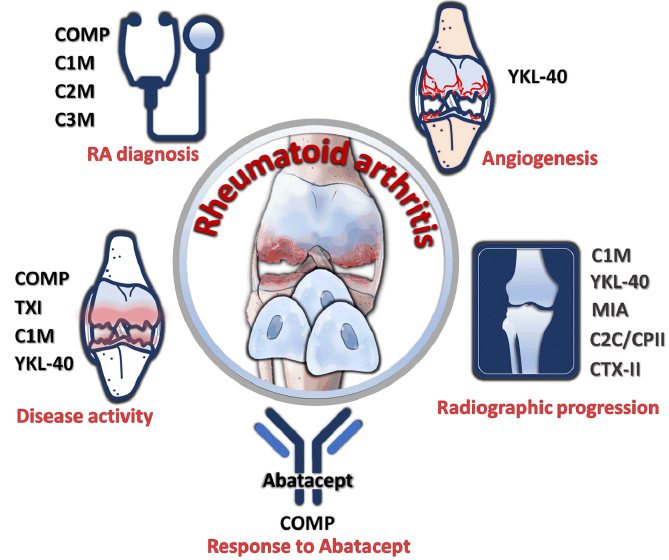
Figure 3. Utility of chondrocyte products as diagnostic and prognostic markers. Cartilage oligomeric matrix protein (COMP), collagen type I (TXI), C1M, C2M, C3M, YKL-40, MIA, C2C/CPII ratio, and